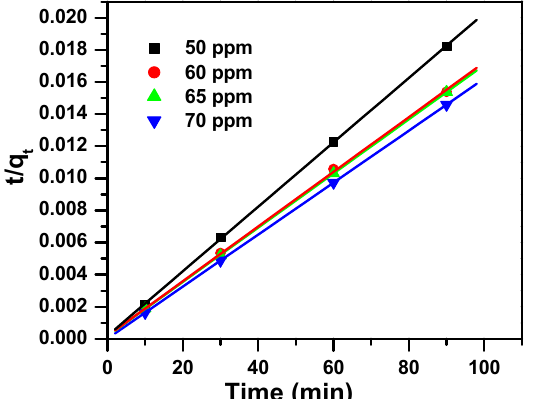
Figure 8. Pseudo-second-order model plot showing the effect of contact time and initial dye concentration of MB removal by Fe 2 (MoO 4 ) 3